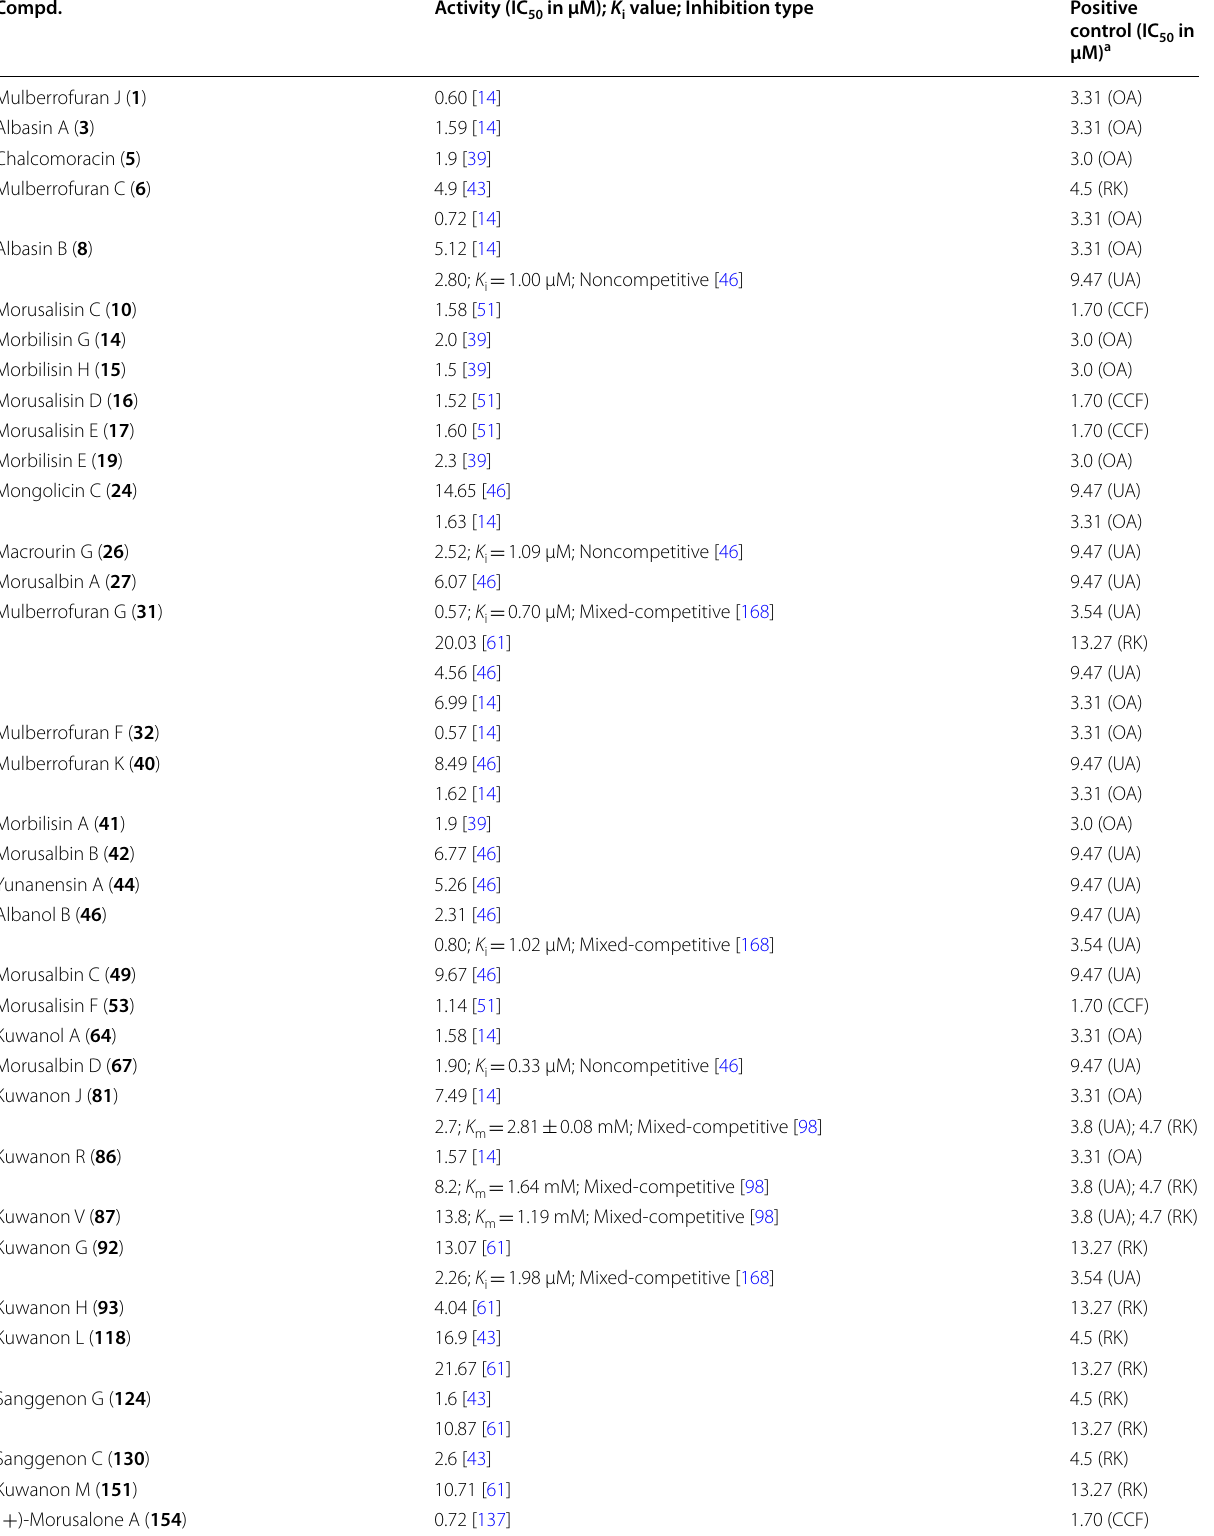
Table 6 Inhibitory activities of MDAAs against PTP1B